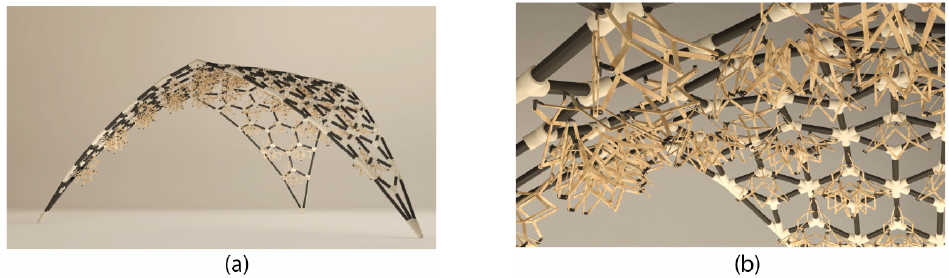
Figure 1. Carrier component structure: ( a ) detailed design of a discrete carrier surface as a support structure; and ( b ) aggregation of a single adaptive component over the surface.